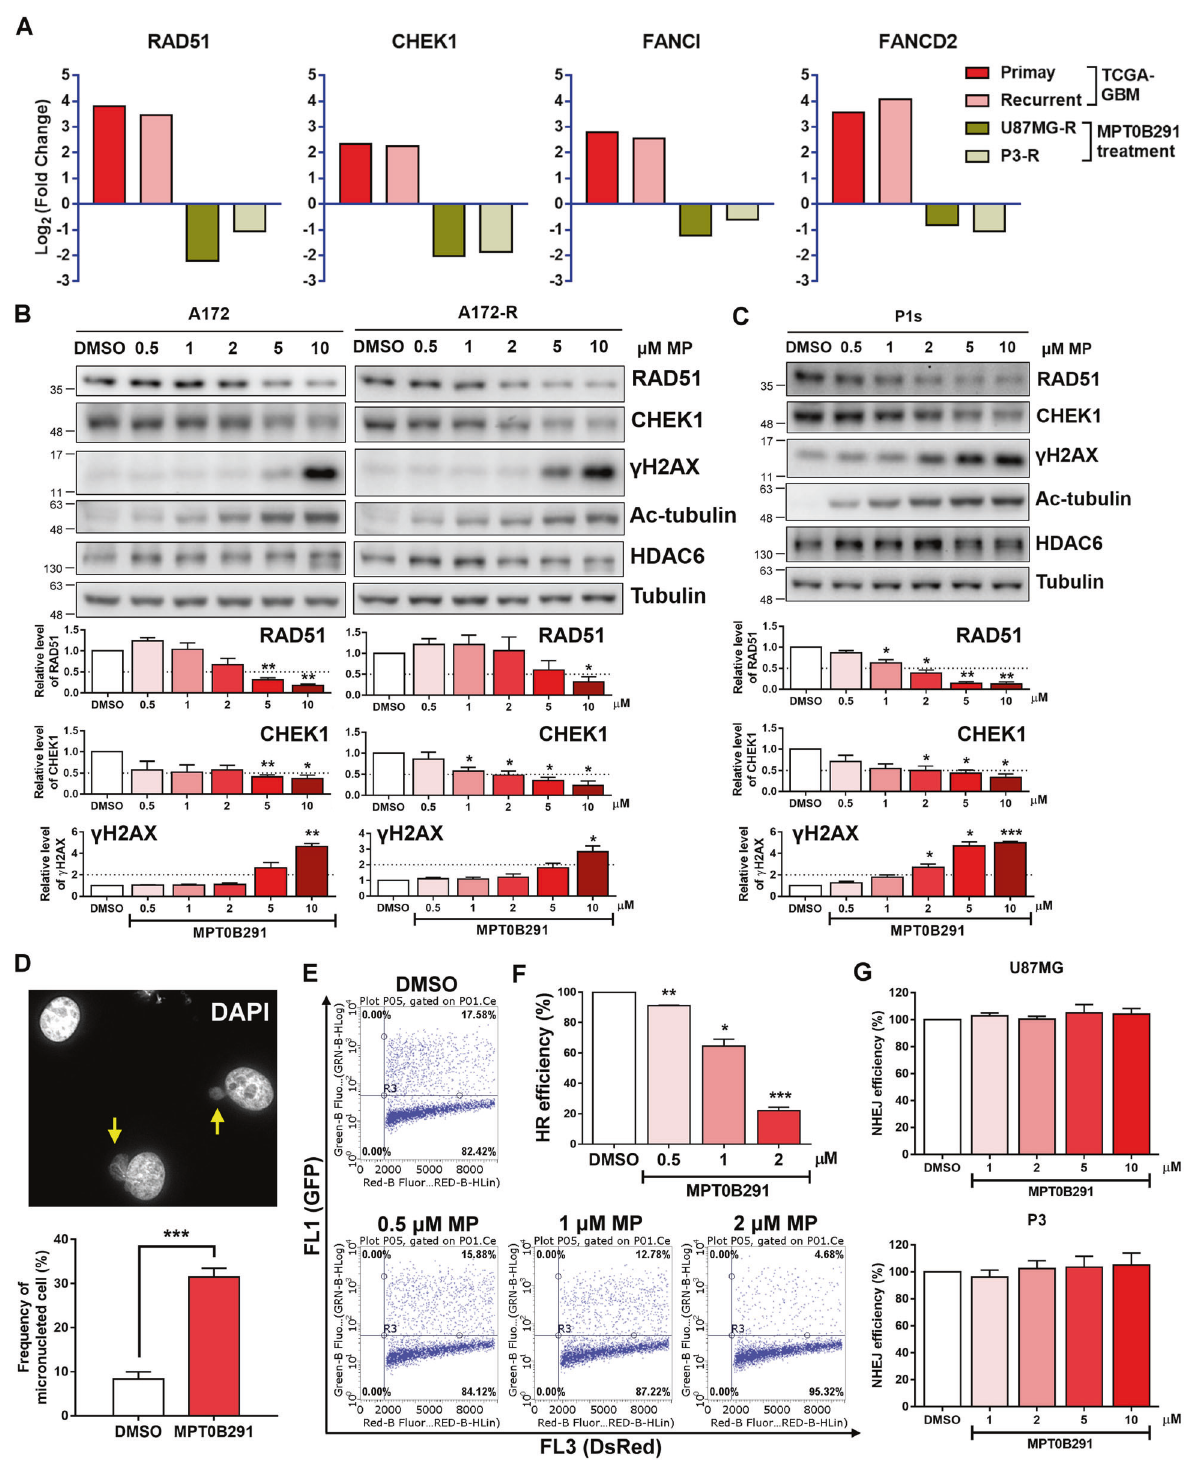
Fig. 2 MPT0B291 decreases DDR gene expression and induces DNA damage. A The fold change in the expression of RAD51, CHEK1, FANCI, and FANCD2 in TCGA-GBM dataset of primary and recurrent tumor samples, and in MPT0B291-treated U87MG-R and P3-R cells. B A172, A172- R, and C P1s cells were treated with the indicated doses of MPT0B291 for 24 h, and the protein levels of RAD51, CHEK1, γ H2AX, Ac-tubulin, HDAC6, and tubulin were analyzed by western blotting (upper panels). Quantitative results (normalized to tubulin) of RAD51, CHEK1, and γ H2AX from three independent experiments are shown (lower panels). D U87MG cells were fi xed and stained with DAPI following DMSO or MPT0B291 treatment for 24 h. The number of micronuclei (indicated by arrows) was calculated and quanti fi ed in more than 600 cells from three independent experiments. E HR assay was performed after the treatment with DMSO or indicated doses of MPT0B291. The percentage of F HR and G NHEJ ef fi ciency was calculated as the ratio of MPT0B291 treatment to DMSO treatment and quanti fi ed after three independent